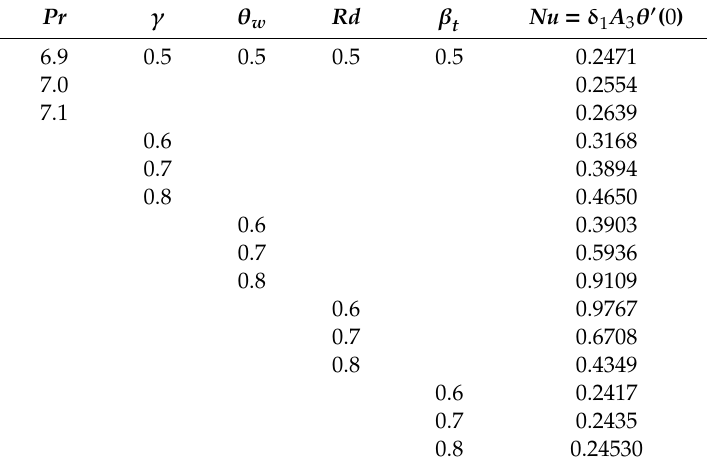
Table 2. Numerical values of Nusselt number against the di ff erent values of parameters, i.e., δ = 0.5, S t = 0.5, and S = 1 1